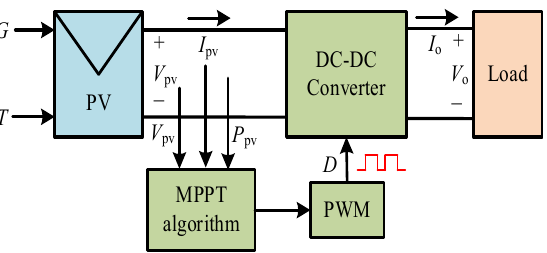
Figure 1. PV system structure.